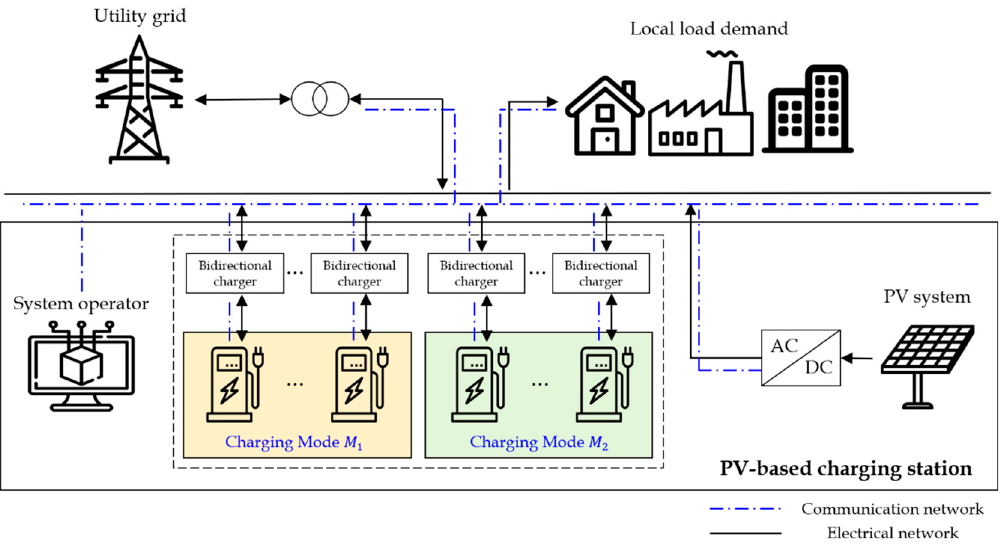
Figure 1. Overall system architecture of the PV-based charging station.